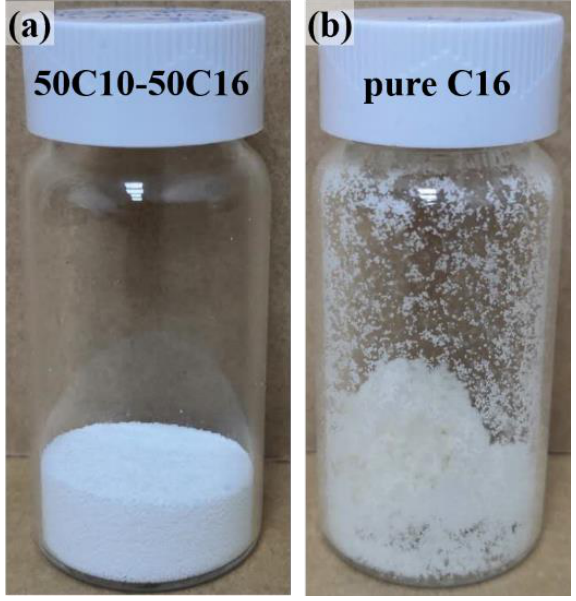
Figure 6. Appearance of the microcapsules fabricated using solvents with different polarities. ( a ) 50C10 – 50C16 mixed solvent, and ( b ) pure C16.